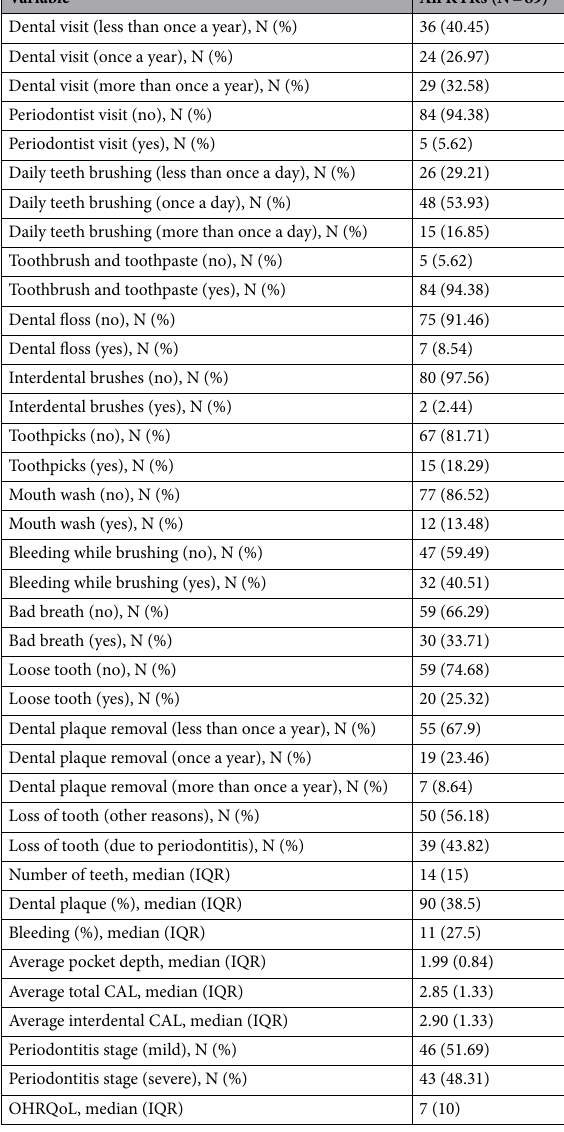
Table 2. Basic characteristics of study participants regarding periodontal status and oral hygiene habits. CAL clinical attachment loss, OHRQoL oral health related quality of